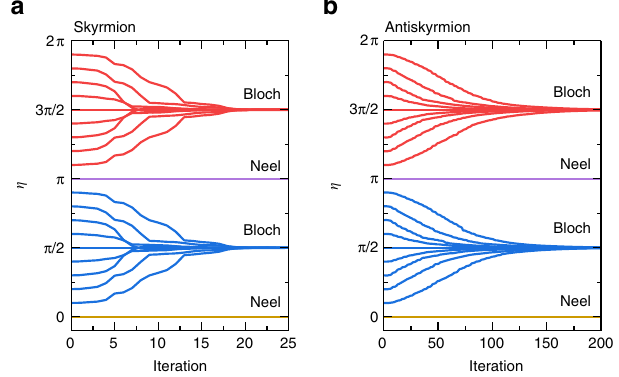
Fig. 5 Helicity η as functions of the iteration for a skyrmions and b antiskyrmions with varied initial η . All of them are relaxed to the Bloch-type state unless they are initially in the Néel-type state. The model is a square element (11 × 11 spins) with the OBC. The parameters are J 2 = − 0.8, J 3 = − 1.2, K = 0.1, and H z =